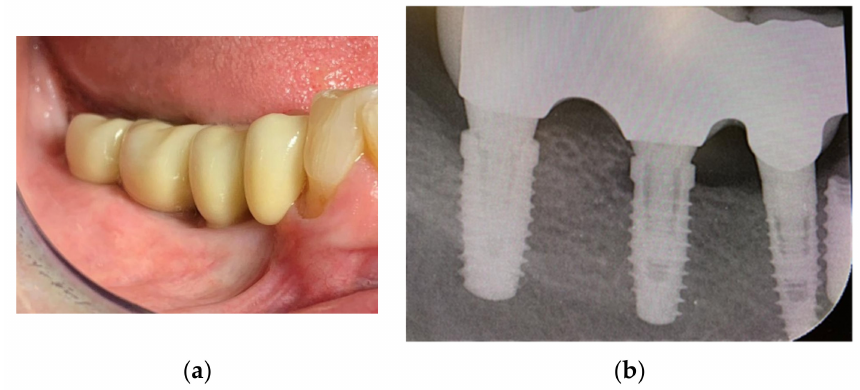
Figure 21. Follow-up at 15 months: clinical view ( a ) and control radiograph ( b